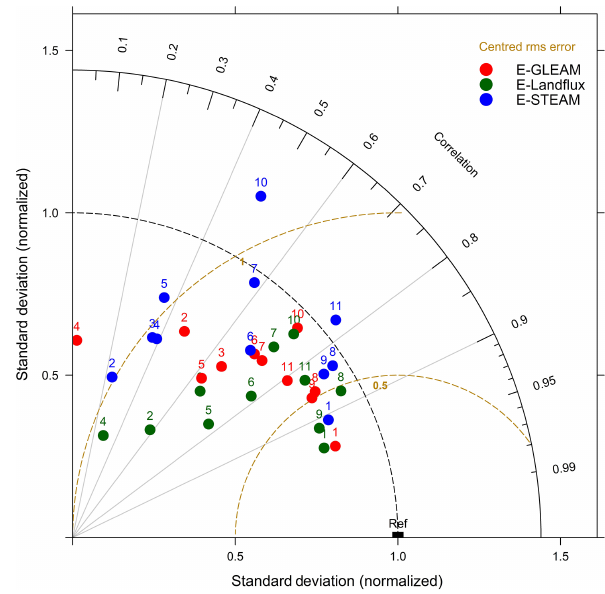
Figure 2. Taylor diagram for mean annual evaporation estimated by Gerrits’ model in comparison to Landflux-EVAL (green cir- cles), STEAM (blue circles), and GLEAM (red circles) for all data (no. 1), evergreen needleleaf forest (no. 2), evergreen broadleaf for- est (no. 3), deciduous needleleaf forest (no. 4), deciduous broadleaf forest (no. 5), mixed forest (no. 6), shrublands (no. 7), savannas (no. 8), grasslands (no. 9), croplands (no. 10), and croplands and natural vegetation mosaic (no.